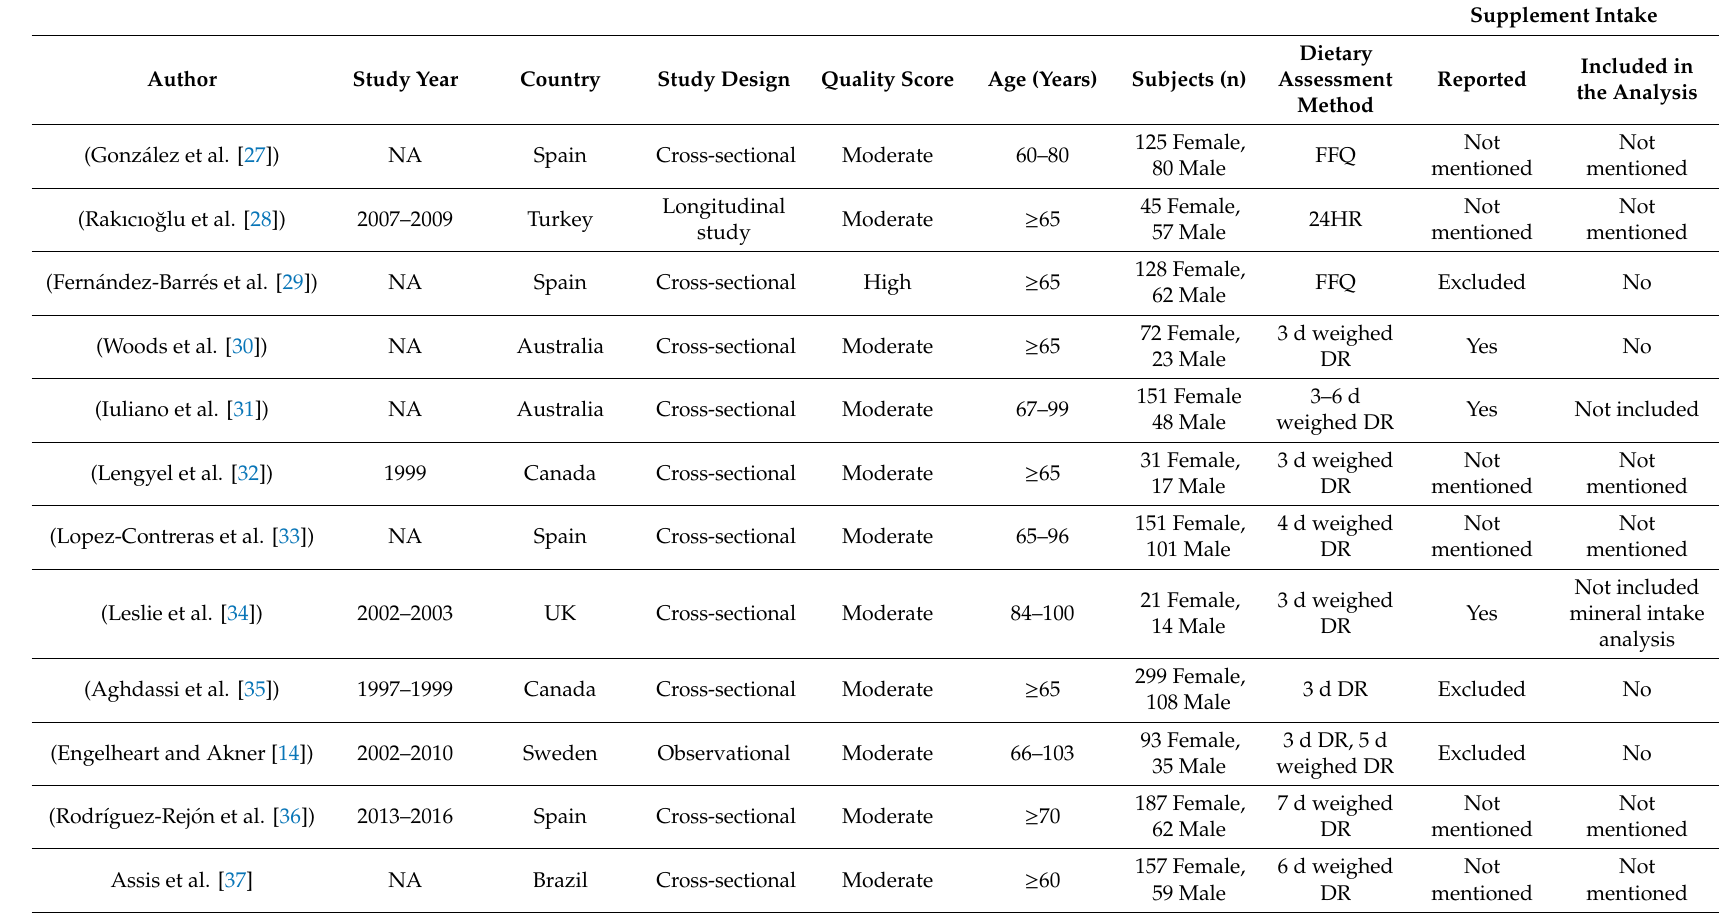
Table 3. Summary of the included studies, evaluating trace mineral intake in older adults living in the